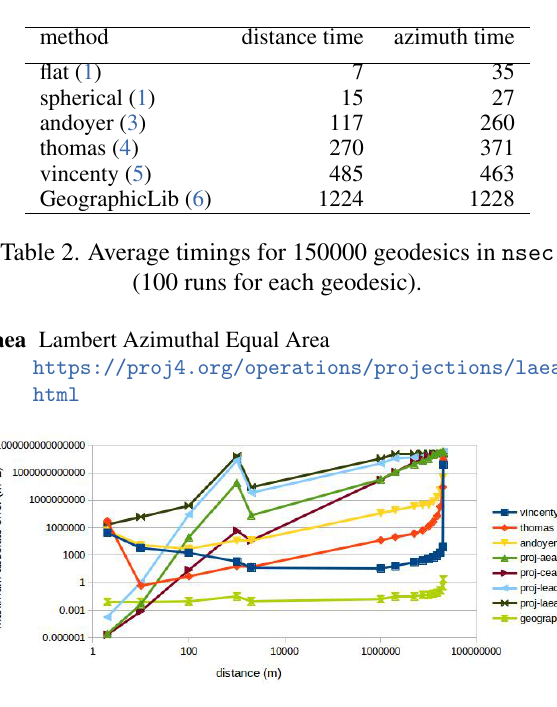
Figure 3. The maximum absolute area error as a function of